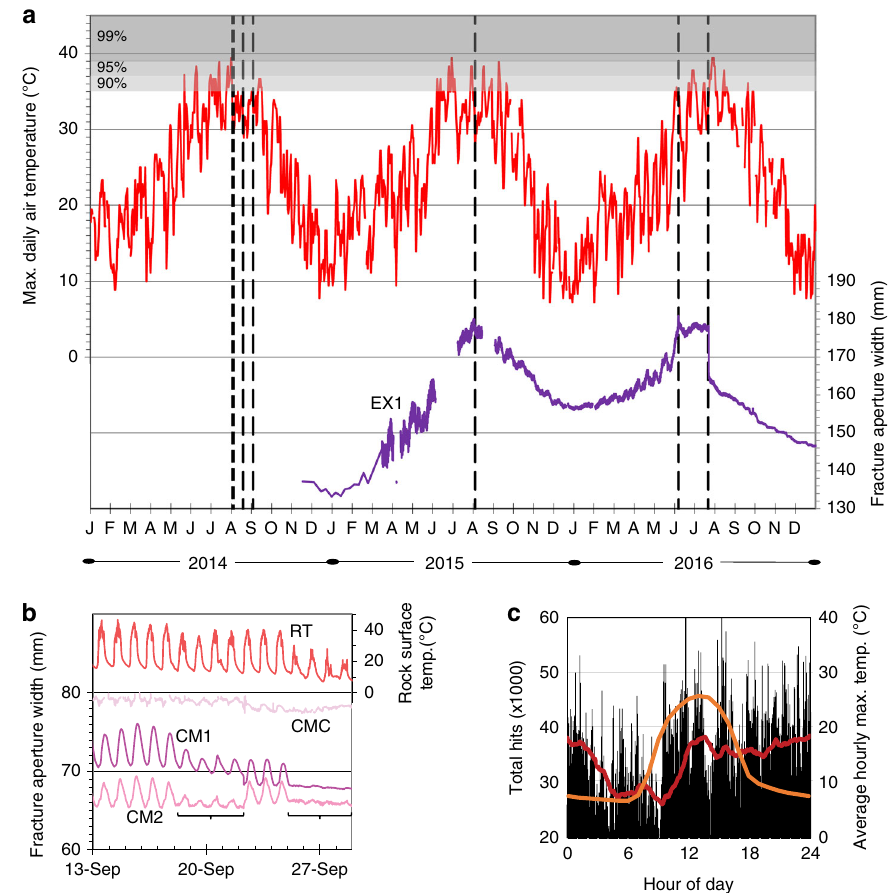
Fig. 4 Time scales of critical and subcritical exfoliation fracture propagation. a Sheet deformation (EX1) correlates with maximum daily temperature with shaded quantiles indicating that all fracturing events (vertical dashed lines) occurred within 10-day time periods containing the hottest 10% of all days during the past 110 years. Initial fracture in 2014 occurred within 24 h of temperatures reaching the 99th percentile of hottest days on record. b Following cyclic diurnal fracture growth (CM1 and CM2), one exfoliation sheet collapsed (brackets) in 2014. Control signal (CMC) indicates small overall error (1 mm) compared to the sheet signals. c Total acoustic emission hits ( n = 48.7 × 10 6 ) from six sensors (Fig. 1c) over 6 months (October 2014 – March 2015) indicate subcritical cracking was ongoing following the 2014 events; sharp increase in 3-h hit running average (red line) peaks with maximum temperatures (orange